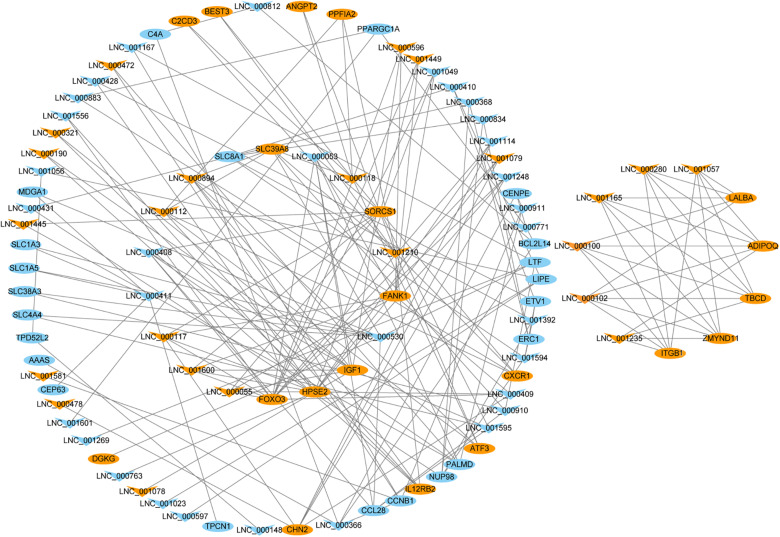
Network plot of candidate lncRNAs and mRNAs. The orange triangles, blue triangles, orange round and blue round represent upregulated lncRNAs, downregulated lncRNAs, upregulated mRNAs and downregulated mRNAs, respectively.